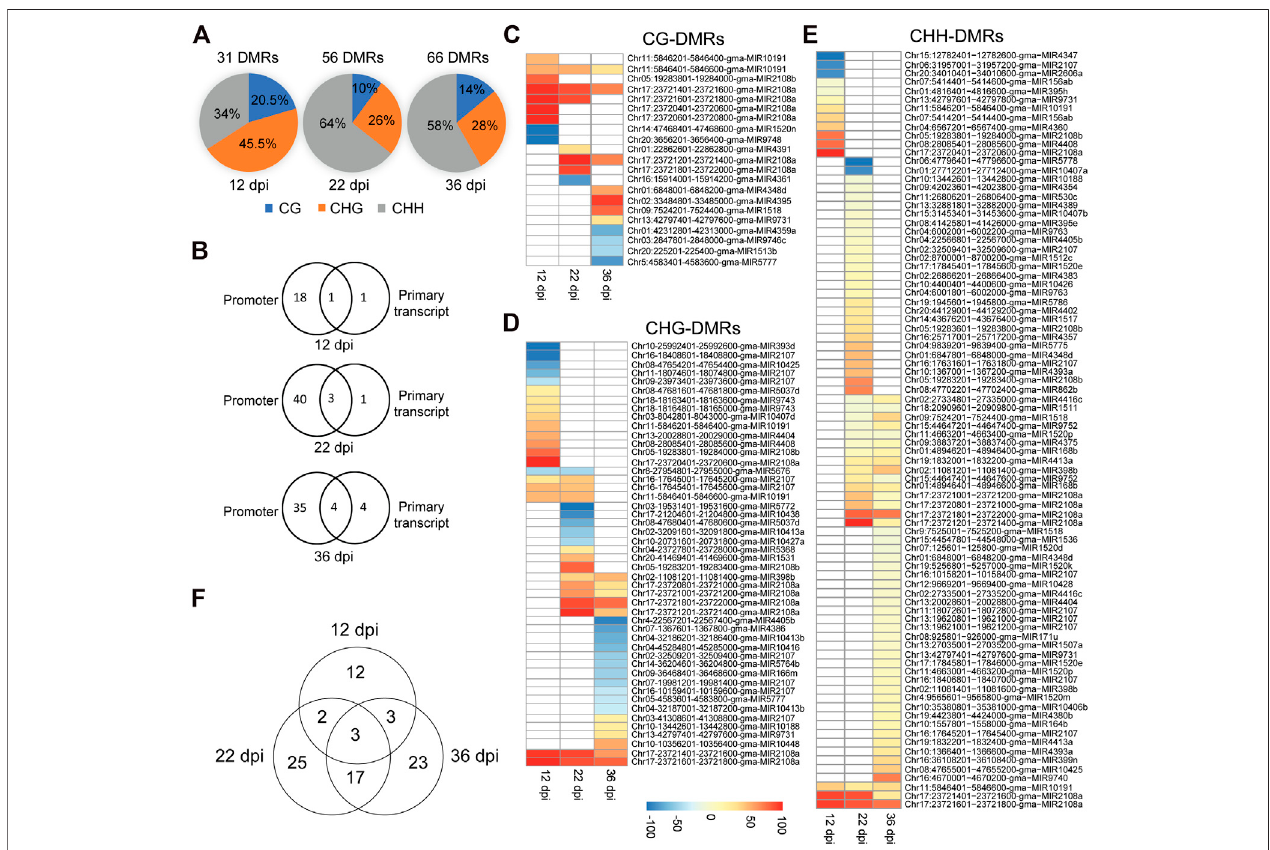
FIGURE 3 | Classi fi cation of differentially methylated miRNAs in soybean nodules. (A) : Distribution of DMRs identi fi ed at 12, 22, and 36 dpi over the CG, CHG and CHH sequence contexts. (B) : Number of differentially methylated miRNAs in the promoter or primary transcript regions at 12, 22, and 36 dpi. (C – E) : Heatmap demonstrations of hyper-and hypomethylated miRNAs in the nodules as compared with root tissues at 12, 22, and 36 dpi in the CG (C) , CHG (D) , and CHH (E) sequence contexts. Note that some miRNAs contain more than one DMR, which could be differentially methylated in different sequence contexts. (F) : Venn diagram showing the overlaps between differentially methylated miRNAs identi fi ed at 12, 22, and 36